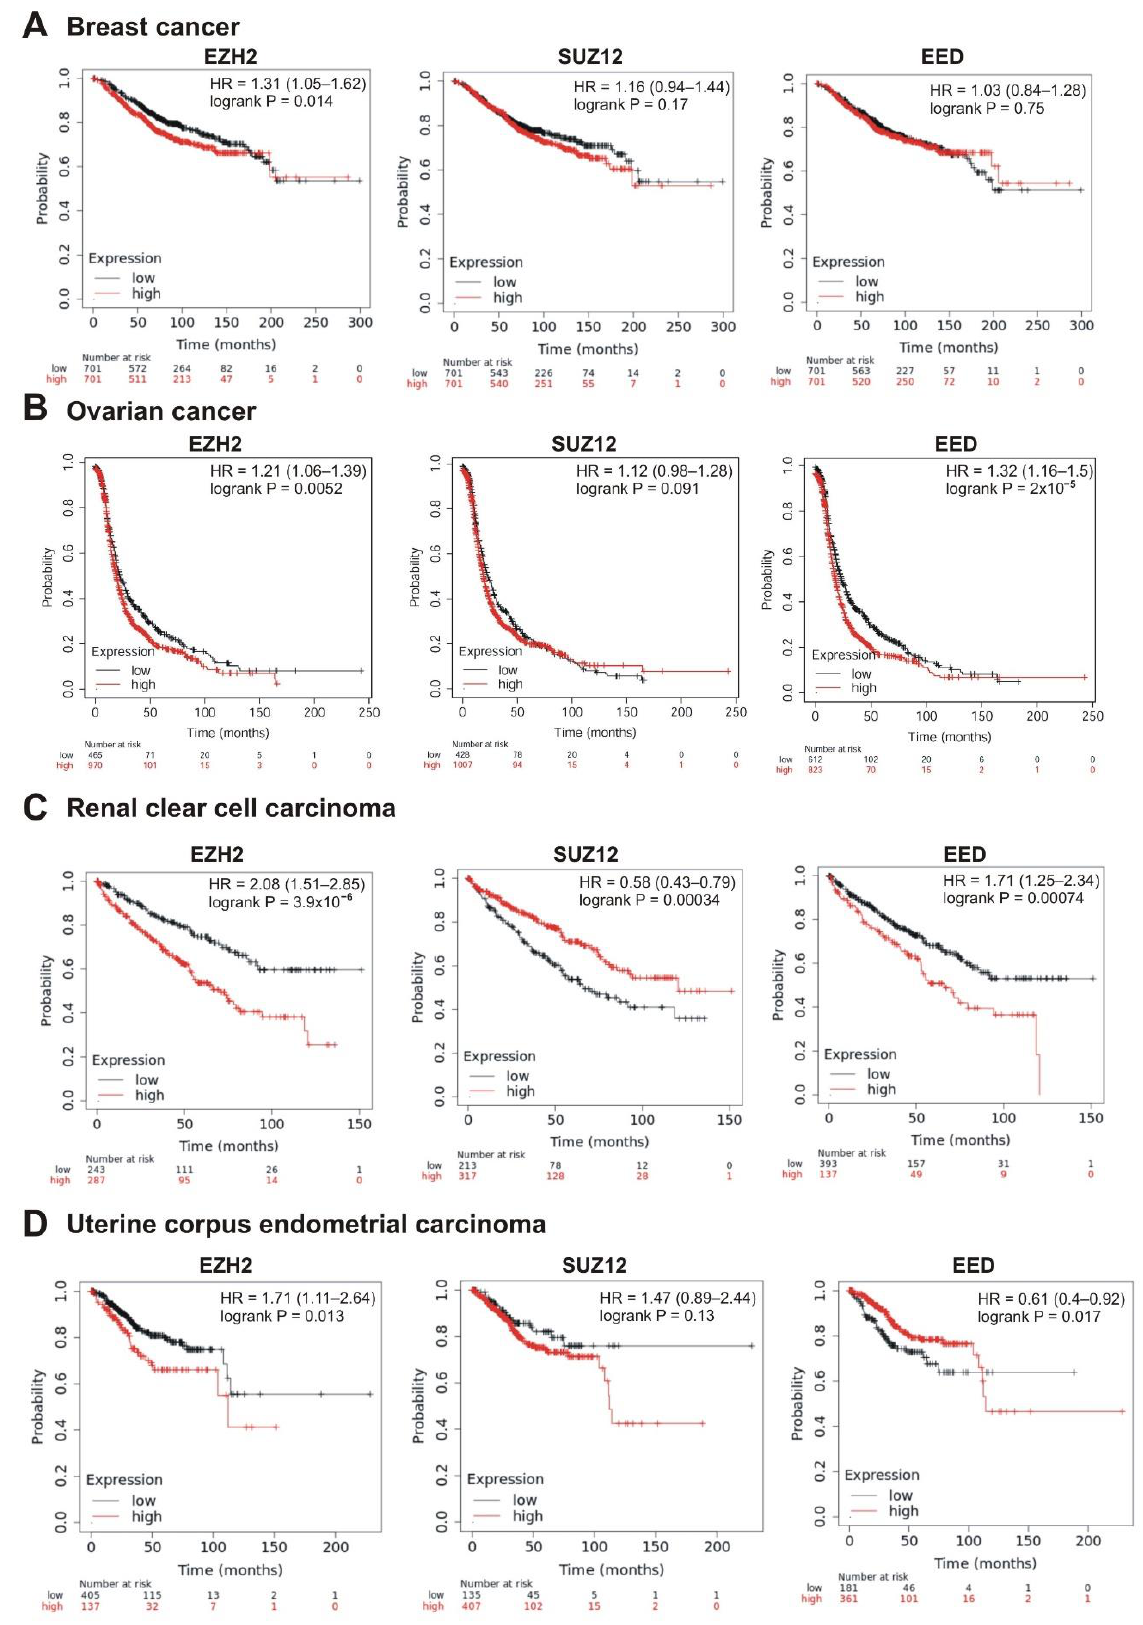
Figure 6. Correlation between the overall survival and the levels of EZH2 , SUZ12 or EED gene expression. ( A ) Breast cancer, ( B ) ovarian cancer, ( C ) renal clear cell carcinoma, and ( D ) uterine corpus endometrial carcinoma.